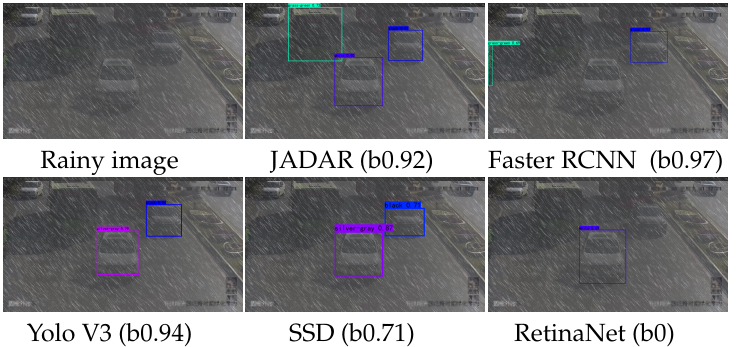
Figure 8. Example 2 of test results of JADAR and object detection methods and domain adaptation methods on the Rain Vehicle Color-24 test set.